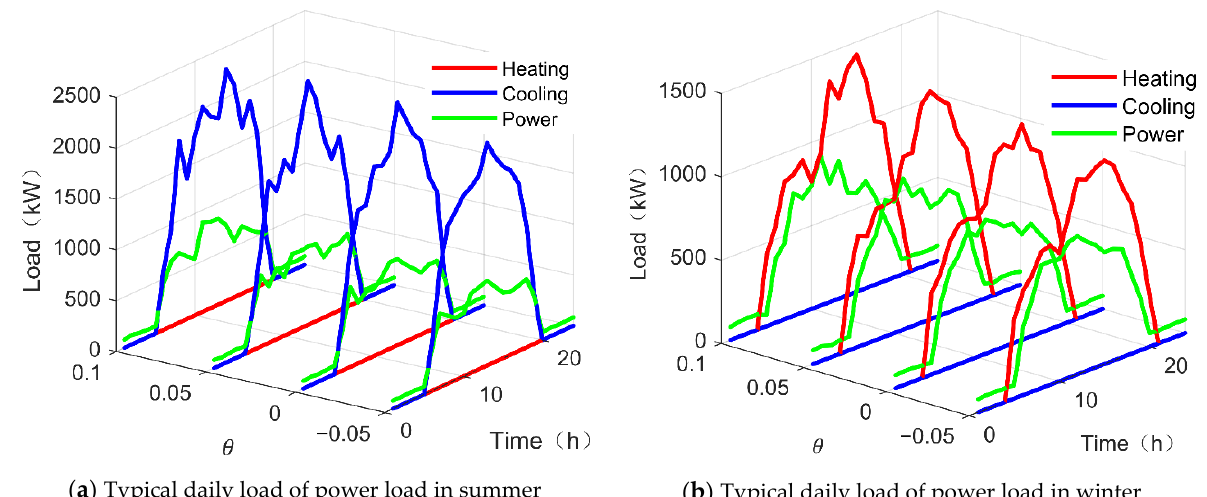
Figure 8. Typical daily load of the power load in the summer ( a ) and in the winter ( b ) at the θ of –0.05, 0, 0.05, and 0.1.